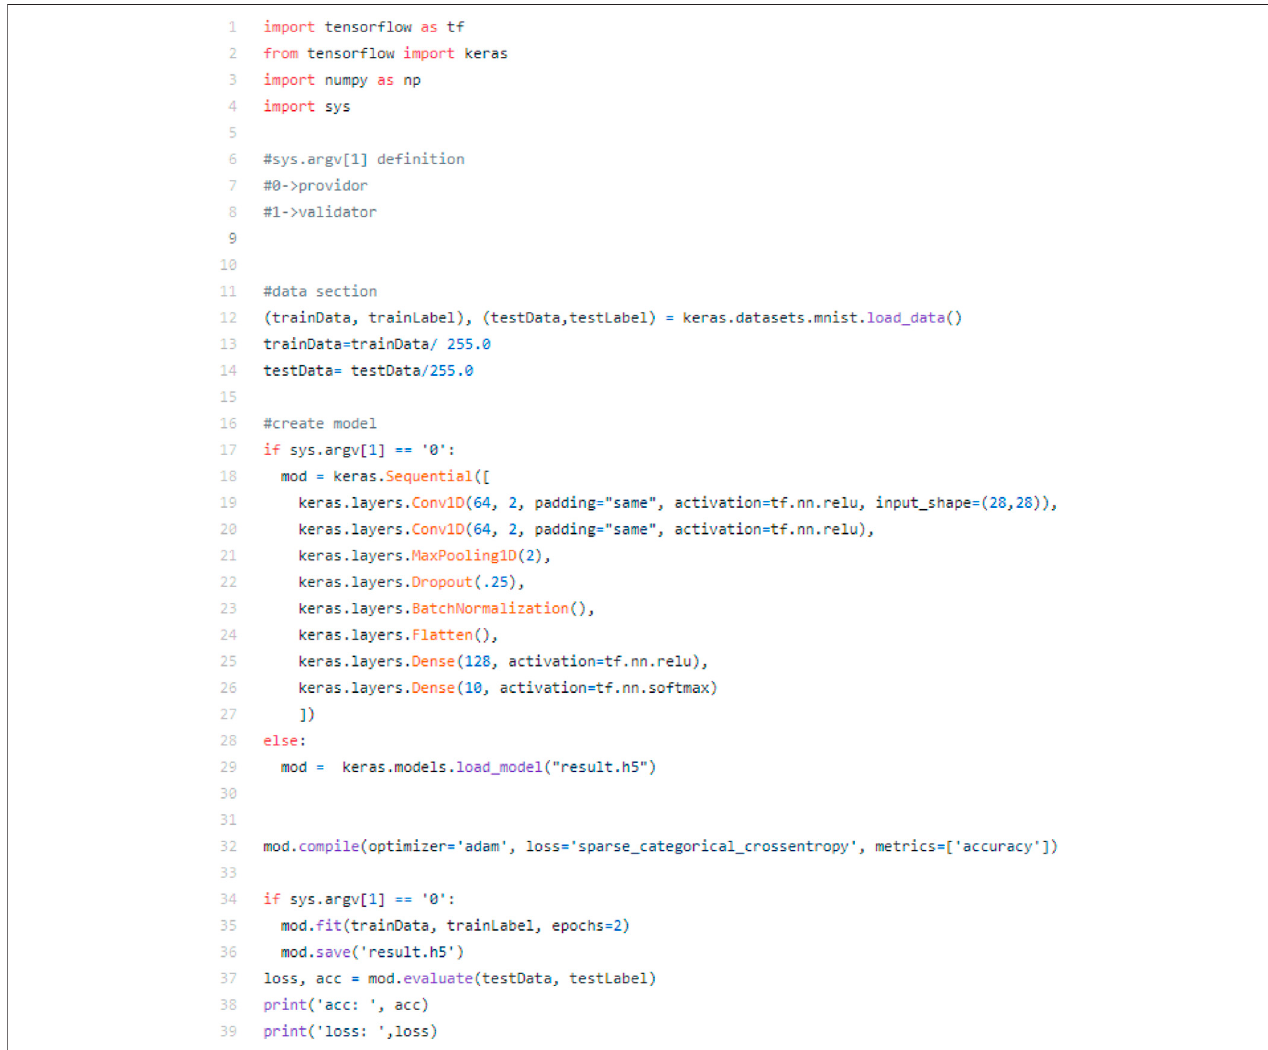
FIGURE 8 | Example machine learning